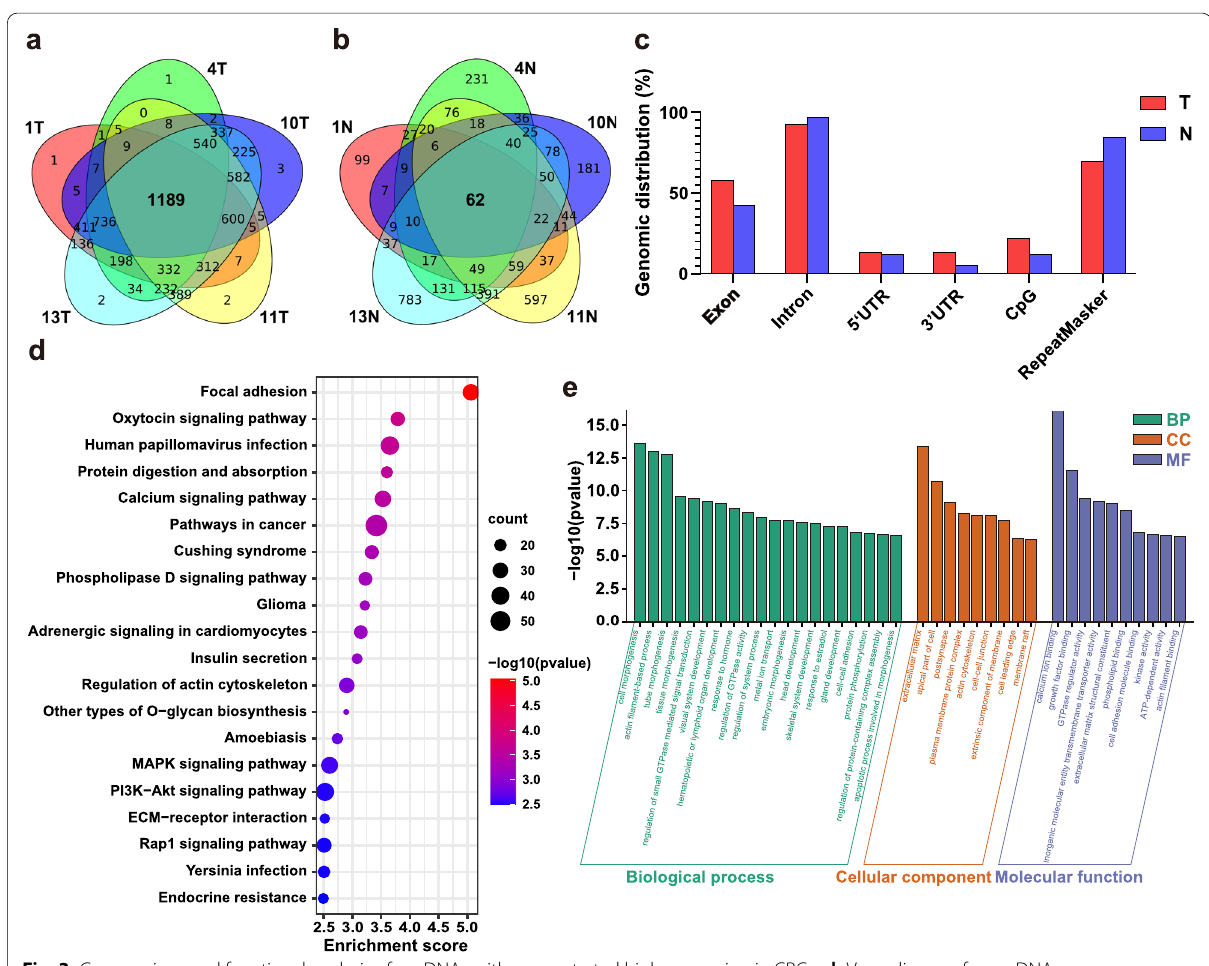
Fig. 3 Gene regions and functional analysis of eccDNAs with concentrated high expression in CRC. a - b Venn diagram for eccDNA sequences common to each sample in tumor group and N, respectively. c Distribution of eccDNAs intersected in tumor group and N in the indicated genomic regions. d Scatter plot of enriched KEGG pathways statistics for genes ( n 1189) contained in eccDNAs shared in each tumor group. e GO = functional classification of genes (n 1189) contained in eccDNAs shared in each tumor =